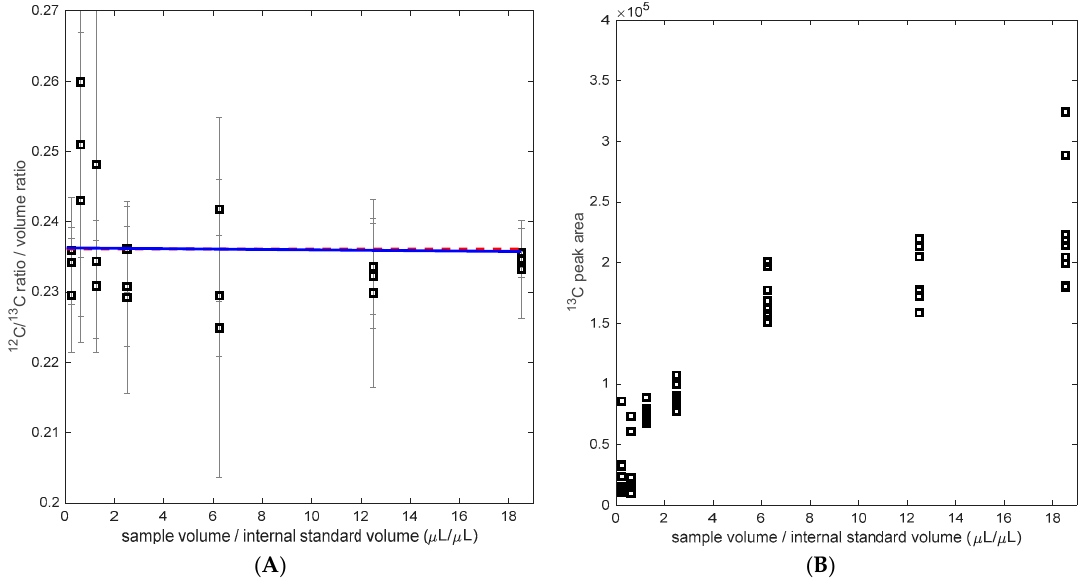
Figure 3. ( A ) Calculated 12 C/ 13 C ratio (measured ratio divided by the volume ratio) as a function of the volume ratio 12 C/ 13 C, in blue the regression assuming an influence of the matrix (H 1 ), H 0 in red. ( B ) 13 C peak area with different matrix background (sample/internal standard volume).